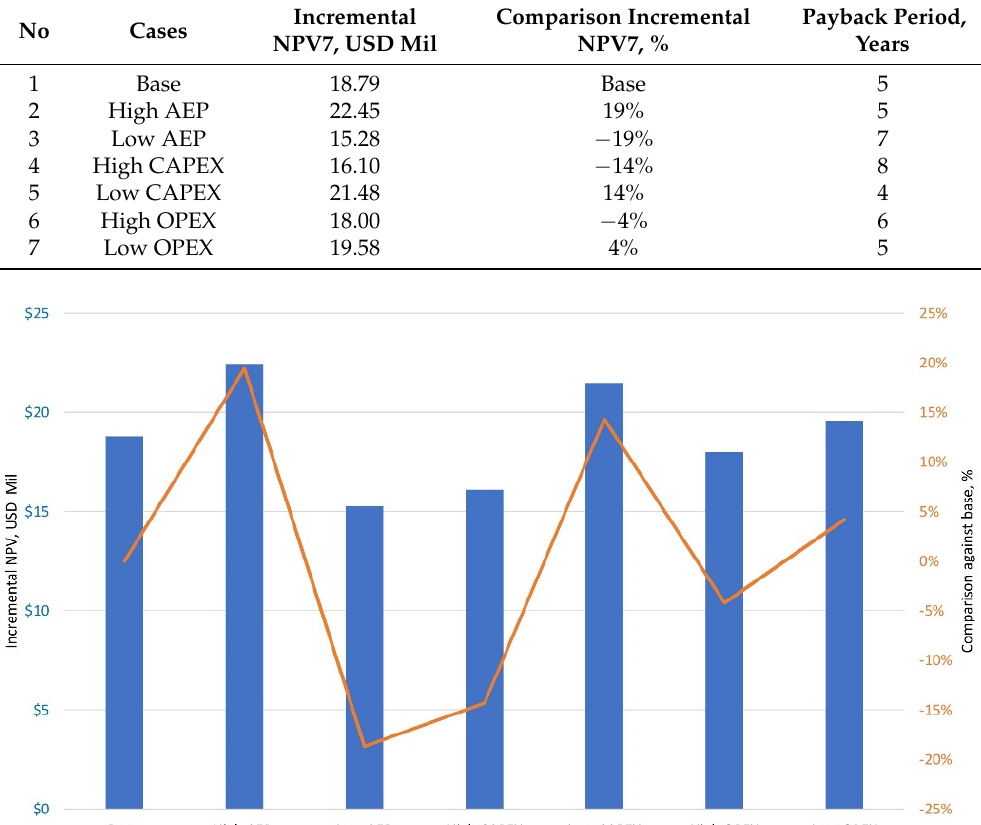
Table 6. Sensitivity analysis.